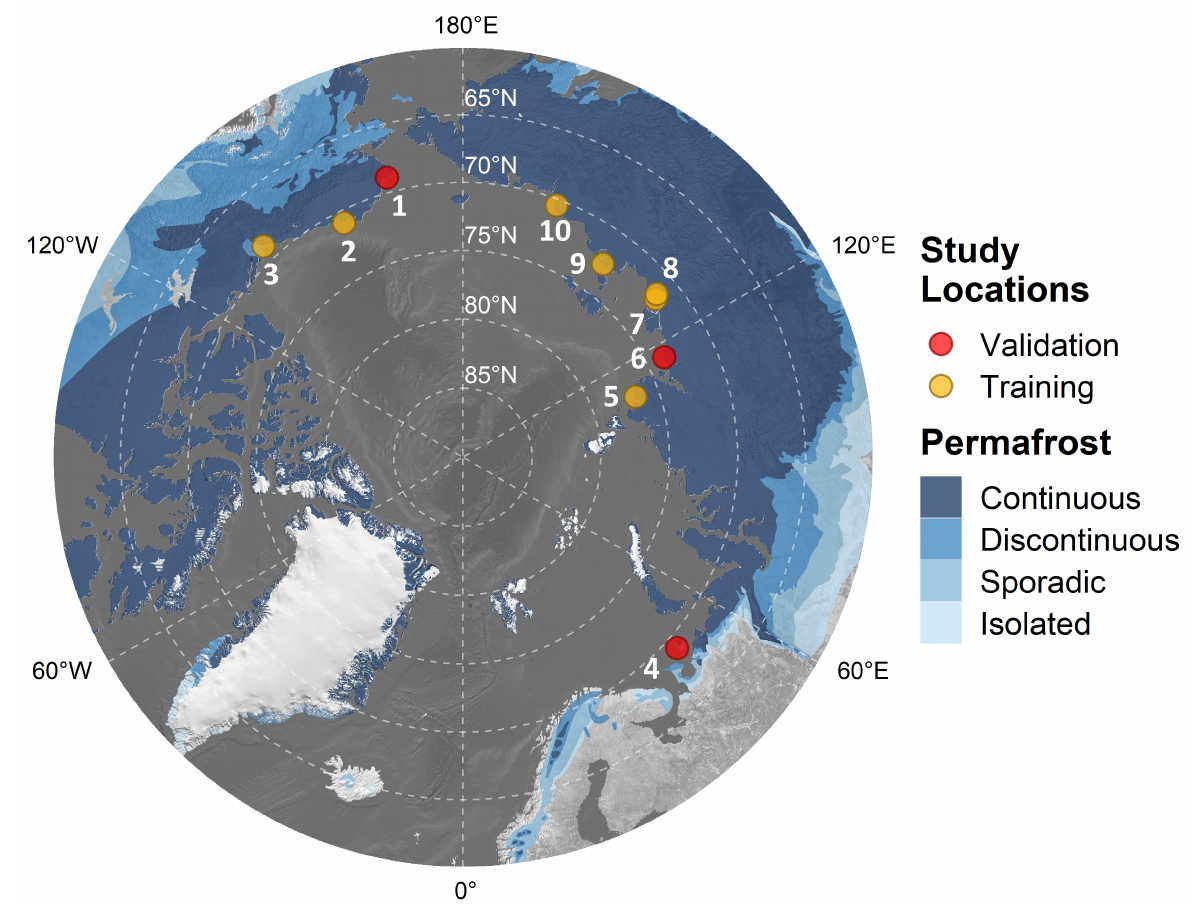
Figure 2. The study area distribution across the Northern Hemisphere together with the circum-Arctic permafrost map by Brown et al. [27] (bluish colored areas). The white bold numbers hereby corre- spond to the area of interest (aoi) number as listed in Table 1. A shaded relief by Natural Earth [28] was utilized as a background map. All data are visualized in a polar Lambert azimuthal equal- area